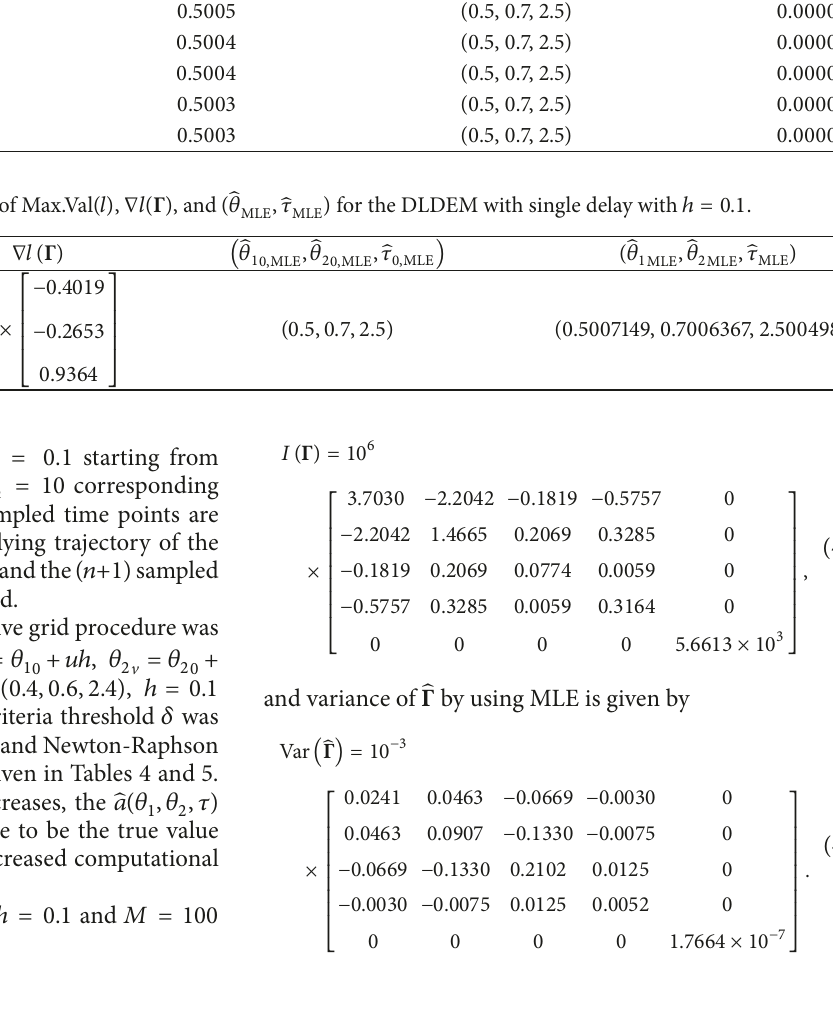
Table 4: Table showing values of Max.Val (𝑙) , the number of equally spaced time points in [0,10] is 𝑛 + 1 = 101 with ℎ = 0.1 . 𝑀